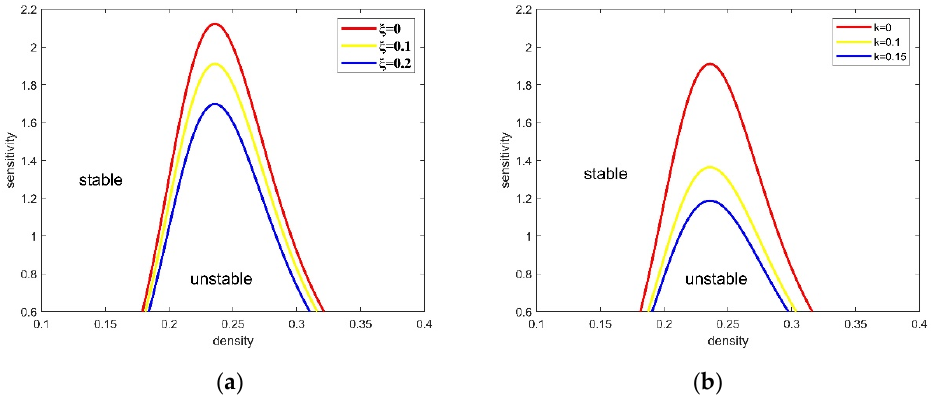
Figure 1. Phase diagram in parameter space ( ρ , α ) . ( a ) k = 0, ( b ) ξ =